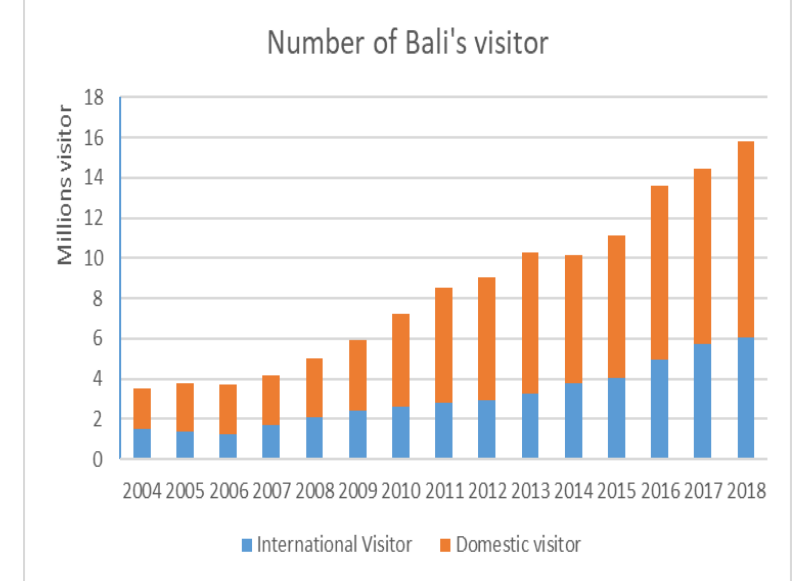
Figure 5 . Number of international and domestic visitors in Bali (BPS, 2018)